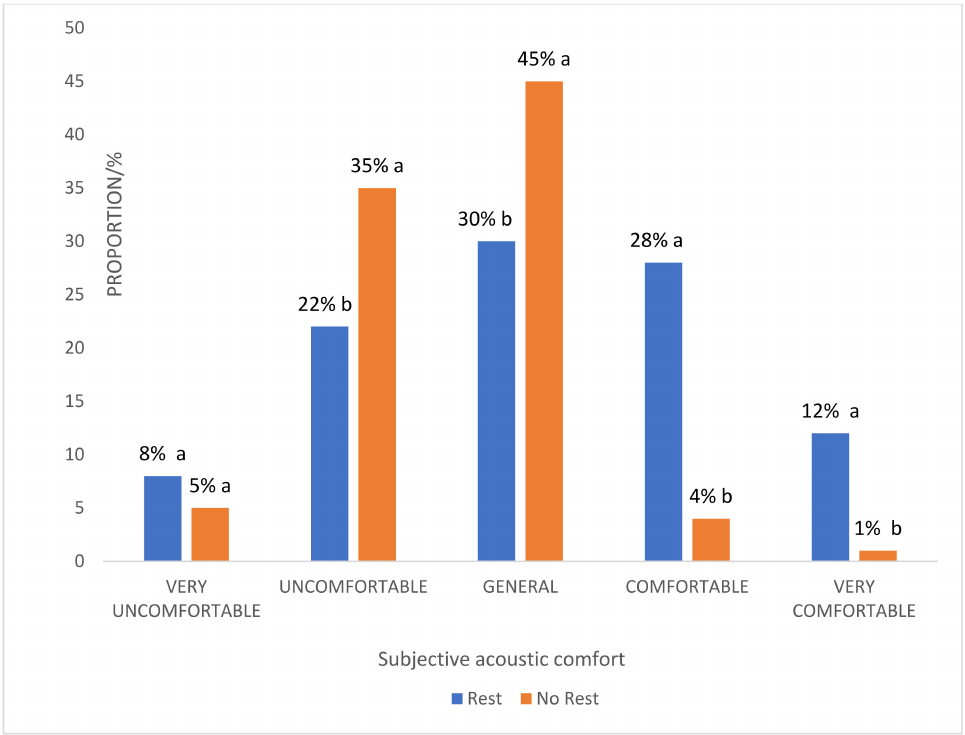
Figure 11. Comparison of the subjective comfort of rested and unrested customers. Different letters represent that the difference between “rest” (Group A) and “no rest” (Group B) reached significance at p < 0.05